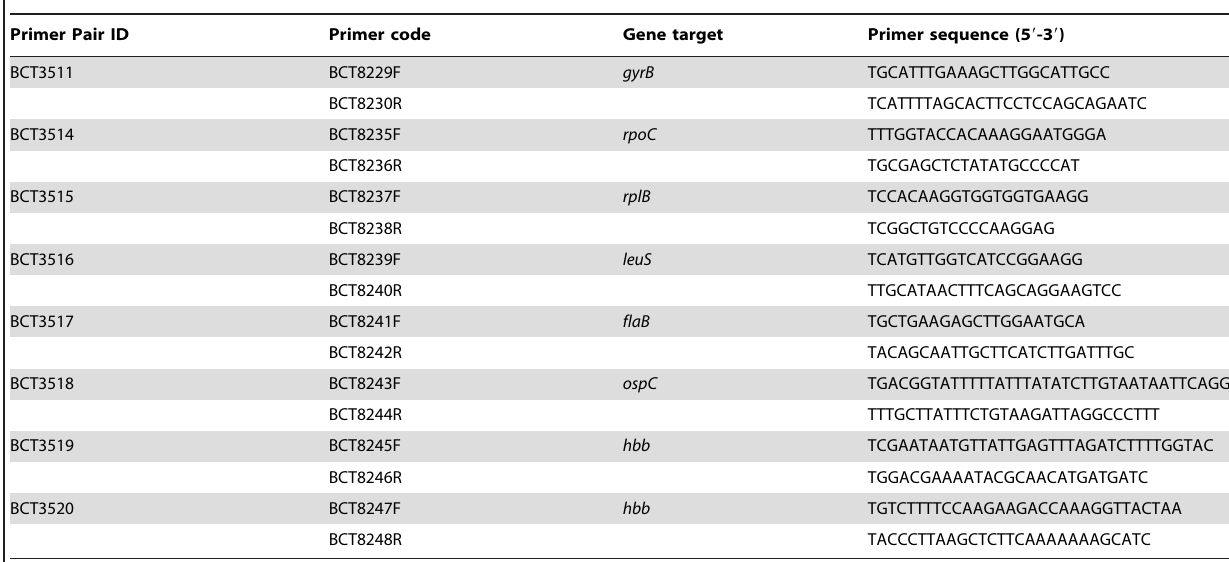
Table 1. Primers used in genotyping